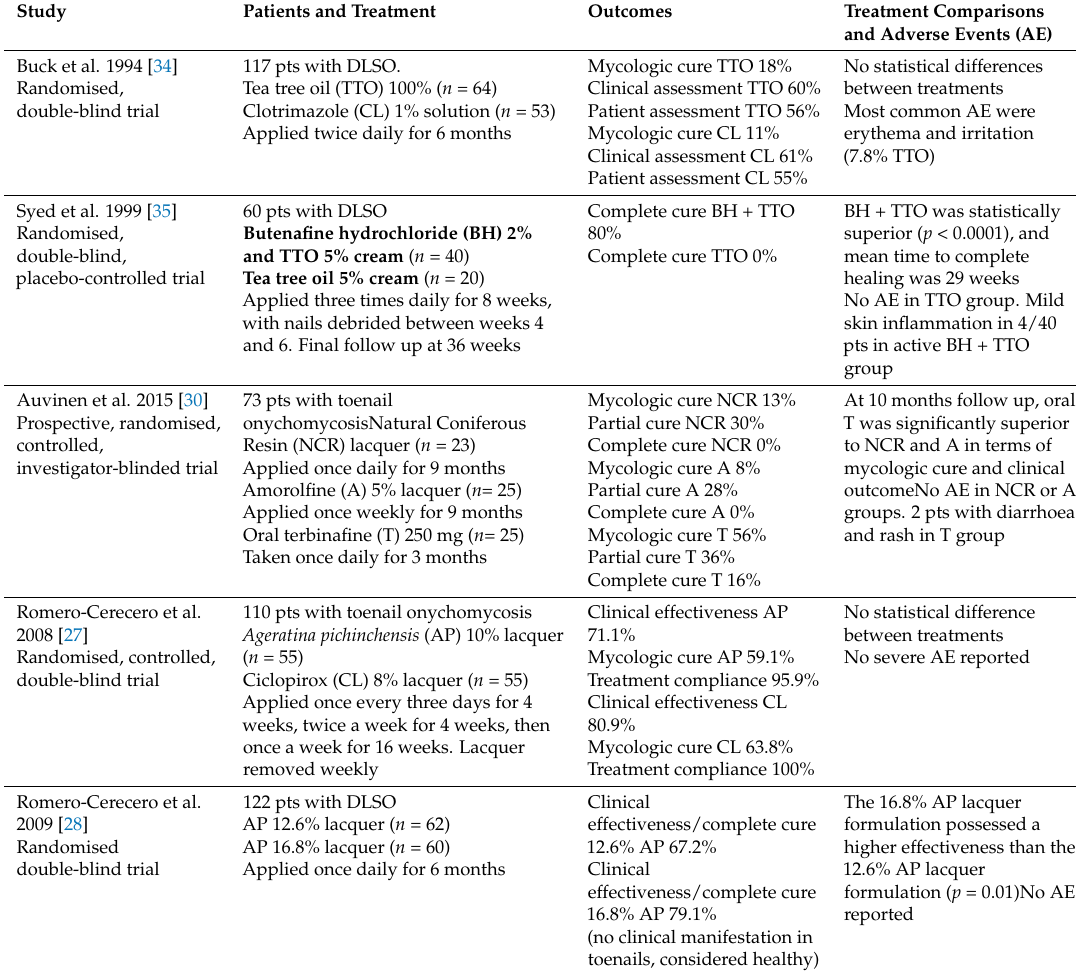
Table 1. Clinical trials investigating natural therapies against